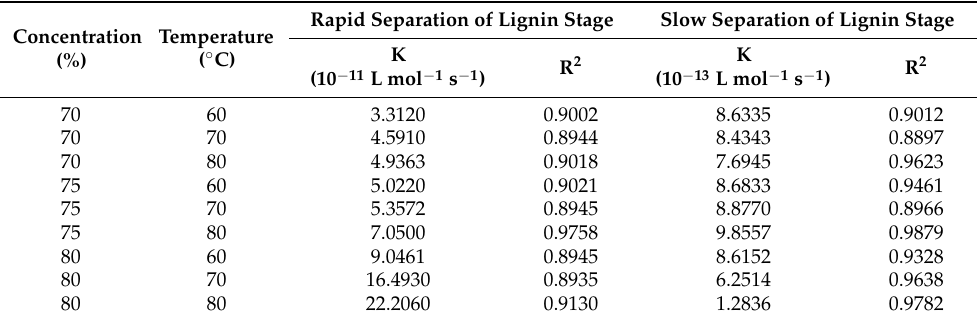
Table 1. Determination of the model parameters for the fast delignification stage and the slow delignification stage based on the experimental